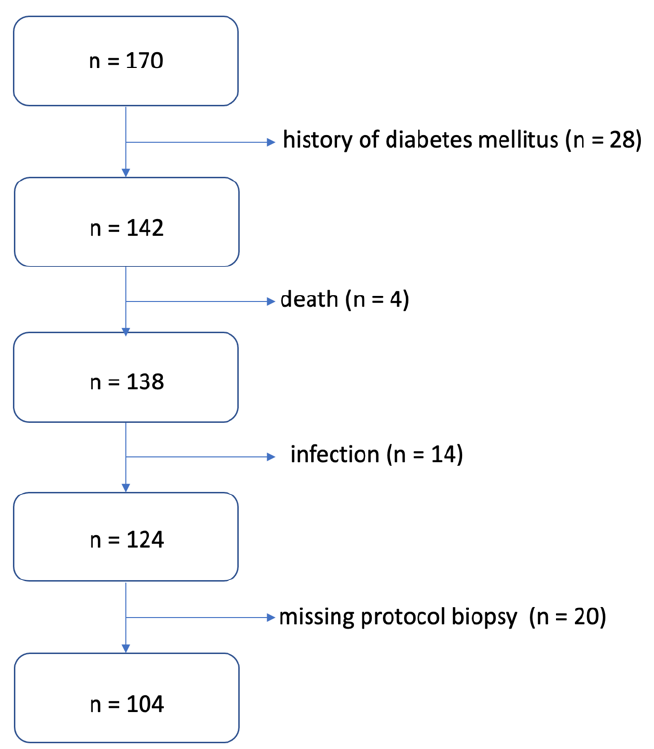
Figure 1. Algorithm for selecting patients for the study.